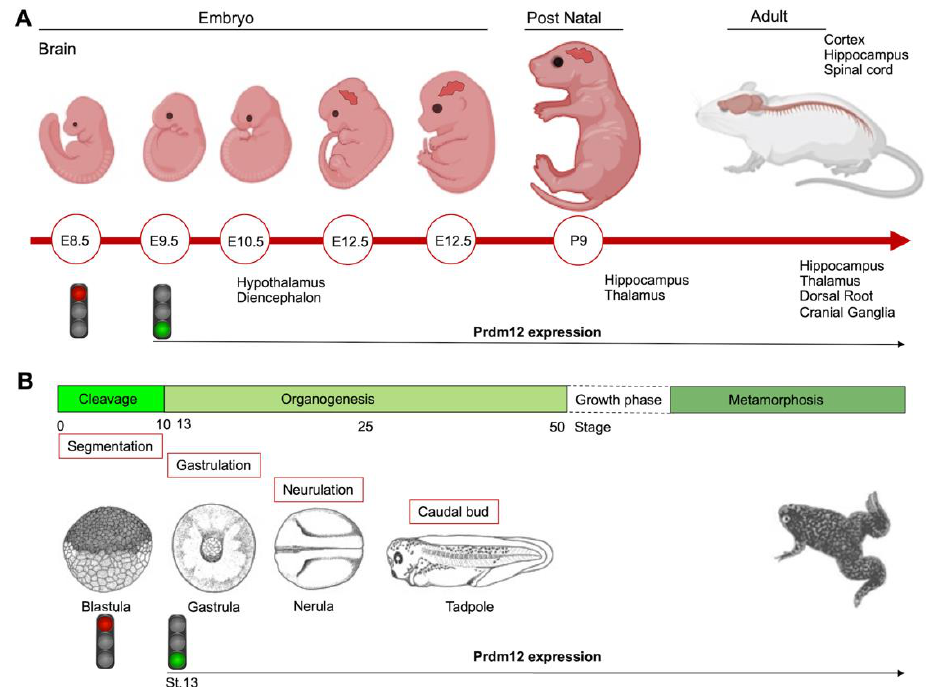
Figure 3. Schematics showing the Prdm12 expression data collected throughout mouse brain development and in different embryonal stages of Xenopus . ( A ) Prdm12 was expressed from early neurogenesis (E9.5) in the developing spinal cord. Additionally, Prdm12 can be detected weakly in the caudal forebrain and midbrain where it increases at E10.5 in precise neuronal progenitor areas. ( B ) prdm12 expression was revealed during the early neurula stage of Xenopus embryos, specifically in the lateral pre-placodal ectoderm after the late gastrula stage (St.13).